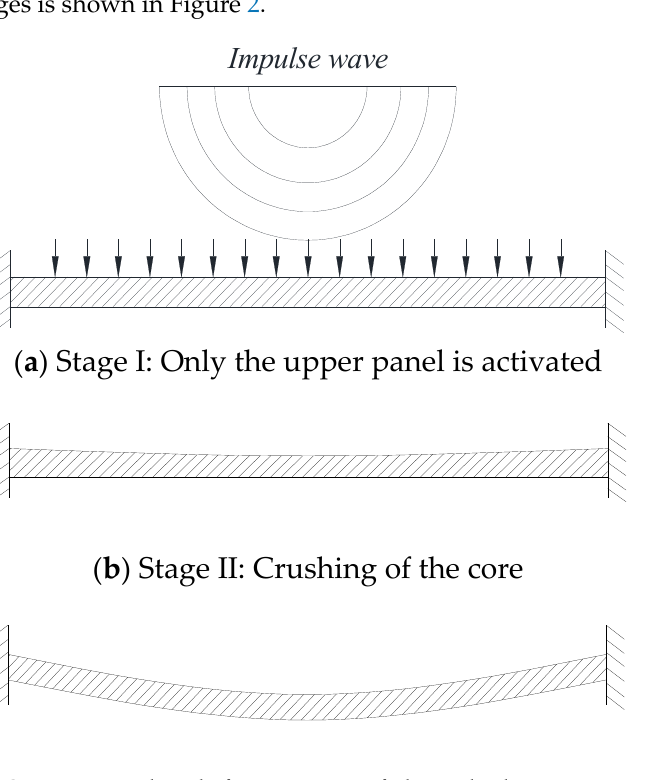
Figure 1. Metal sandwich structure.